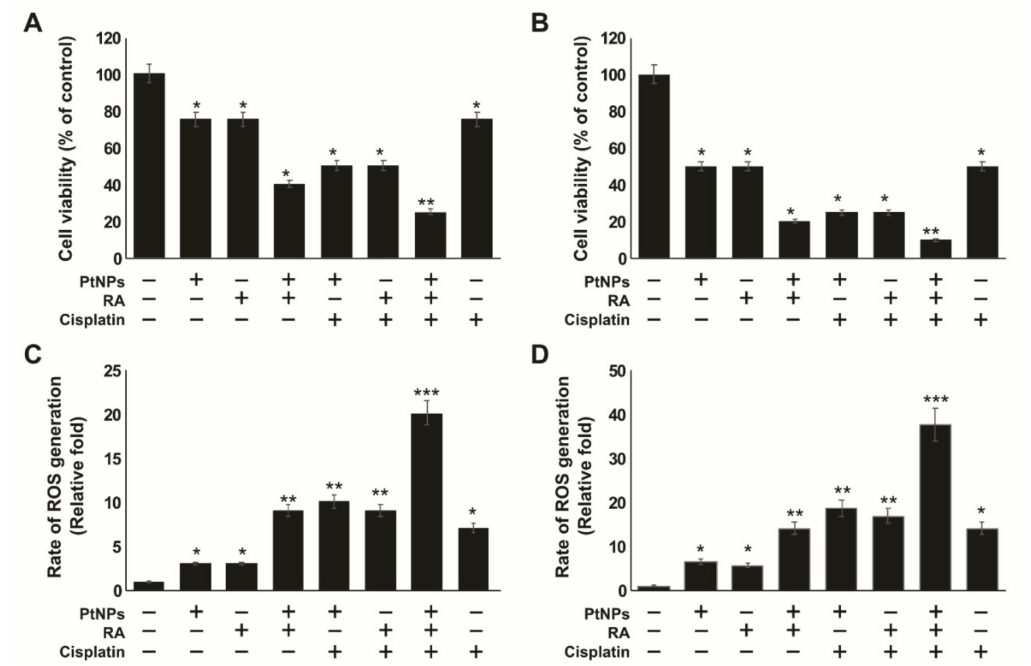
Figure 12. E ff ect of cisplatin on undi ff erentiated and di ff erentiated SH-SY5Y cells. SH-SY5Y cells were pre-incubated with PtNPs (25 µ g / mL), RA (12.5 µ M), or the combination of PtNPs (25 µ g / mL) and RA (12.5 µ M) for 24 h. After preincubation, cisplatin (6.5 µ M) was added to the cells. Cell viability was determined in undi ff erentiated SH-SY5Y cells ( A ) and di ff erentiated SH-SY5Y cells ( B ). Determination of ROS using DCFH-DA in undi ff erentiated SH-SY5Y cells ( C ) and di ff erentiated SH-SY5Y cells ( D